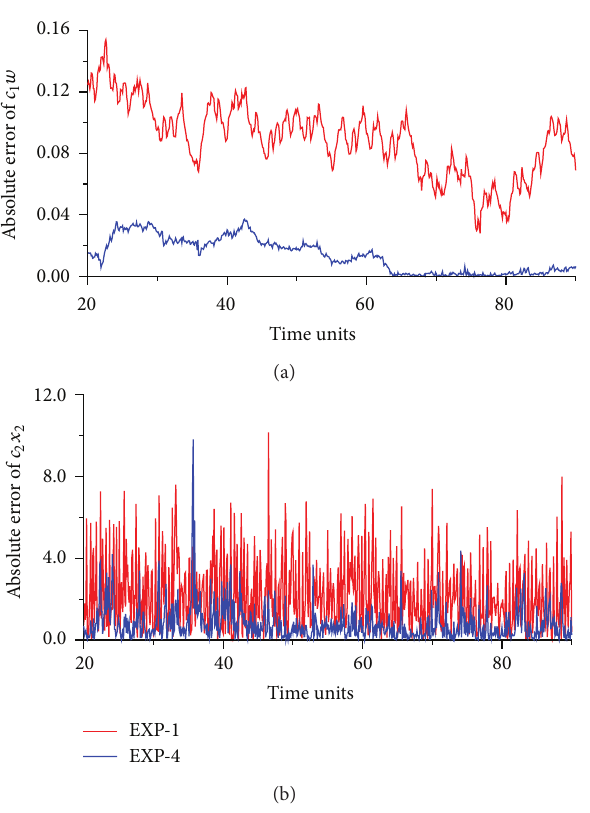
Figure10:SameasFigure 6butfortheEnKFCPEwith20-ensemble size.